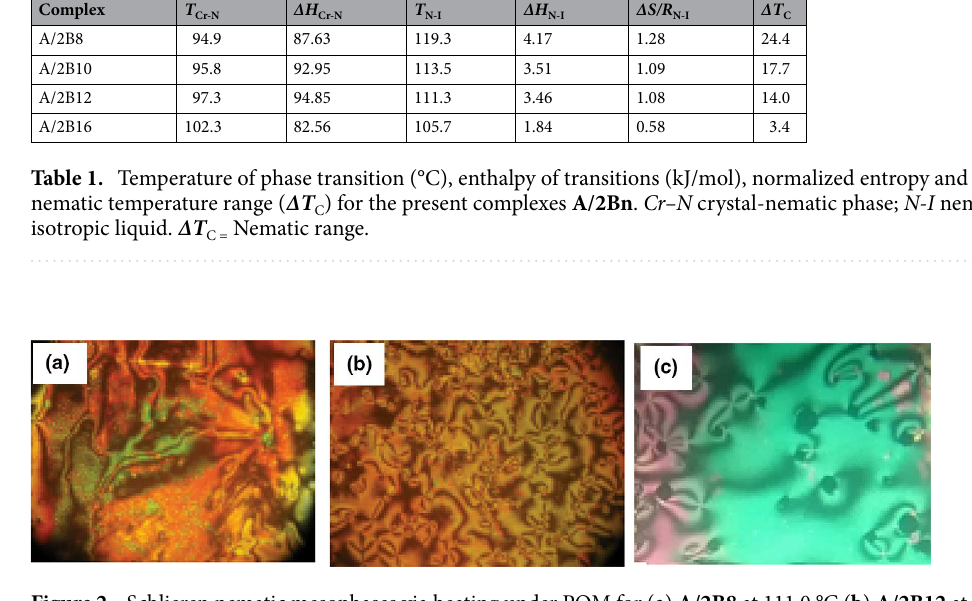
Figure 2. Schlieren nematic mesophases via heating under POM for ( a ) A/2B8 at 111.0 °C ( b ) A/2B12 at 104.0 °C and ( c ) A/2B10 at 108.0 °C.